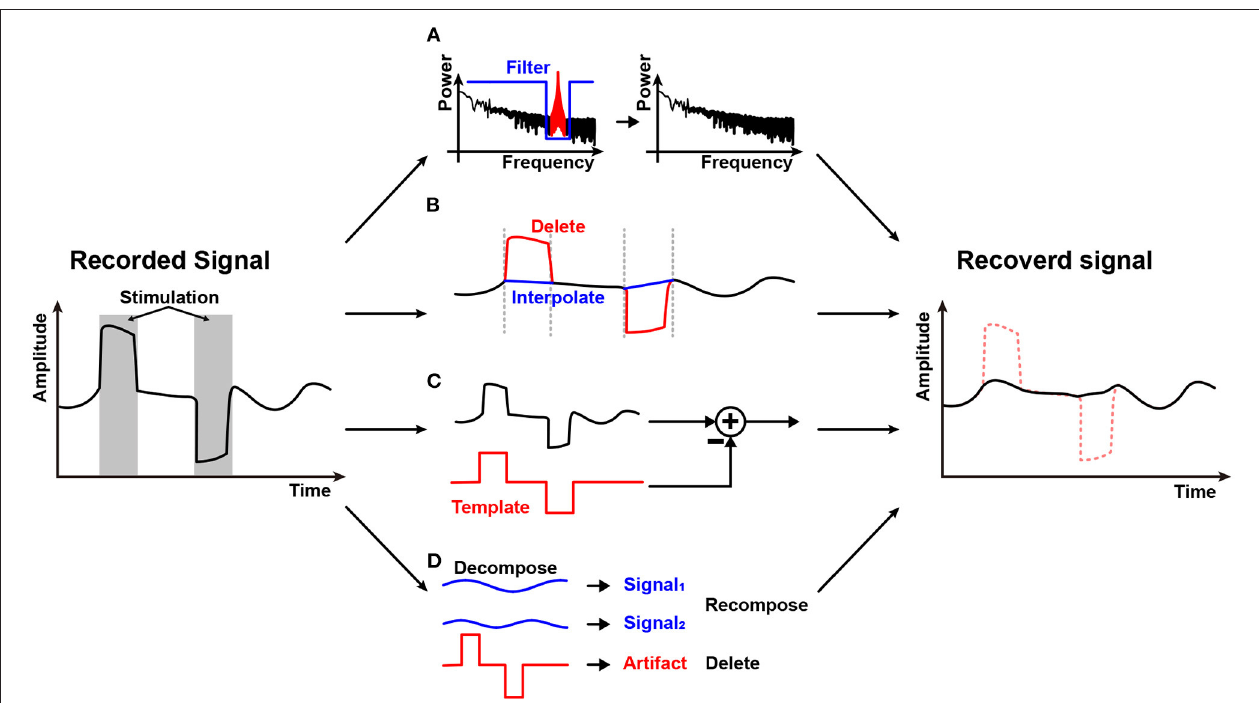
FIGURE 11 | Stimulation artifact removal methods: (A) Spectral filtering; (B) Blanking and interpolation; (C) Template-based subtraction; and (D) Components